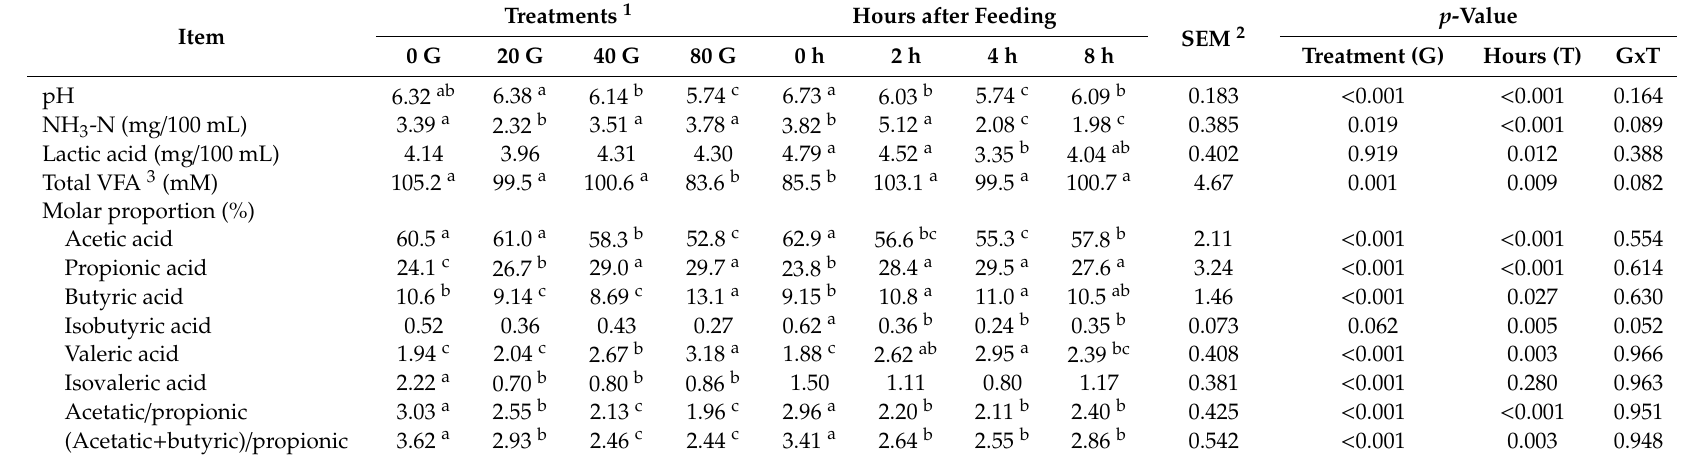
Table 3. E ff ect of feeding glycerin on the ruminal environment of young bulls fed a high level of concentrate.